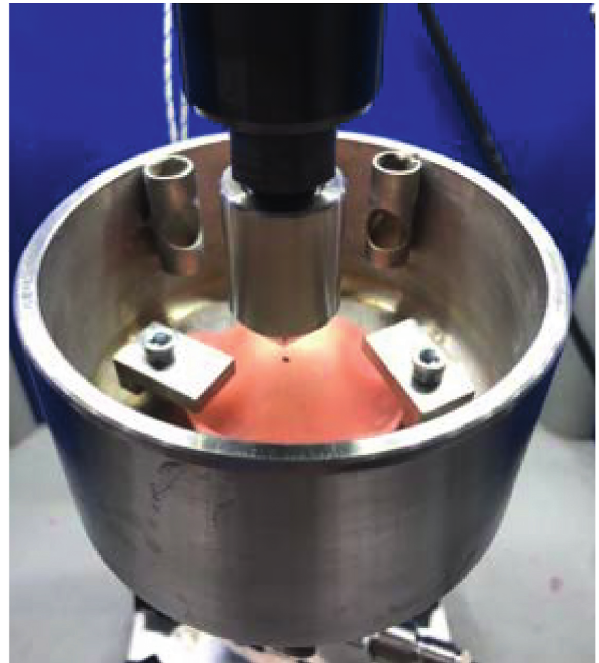
Figure 9: Peak dislocation toward prosthesis